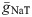
Spiking model channel perturbation results.(A) Spontaneous firing and STO voltage traces from 4 example parameter sets. Colored traces correspond to models circled in Fig 4B. (B) Effect of blocking potassium currents on spontaneous firing frequencies. Left plots with orange points are recreated from Figure 3C of [64] (BK Block), Figure 2D of [24] (KA Block), and Figure 1F of [10] (KERG Block). Right plots with blue points show effects in all good models. Points paired by lines indicate each model. Traces correspond to the orange and green models shown in (A), for each of the channel block conditions. (C) Effect of positive and negative scaling of depolarizing conductances (NaT, CaL and HCN) on spontaneous firing frequency. Each square shows a different scaling factor applied to g¯NaT, with 9 scaling factors ranging from 0 to 2 applied to all 727 good models. Within each square, x-axis shows scaling of g¯CaL and y-axis shows scaling of g¯HCN. Colors indicate mean change in frequency from default value for all 727 models.